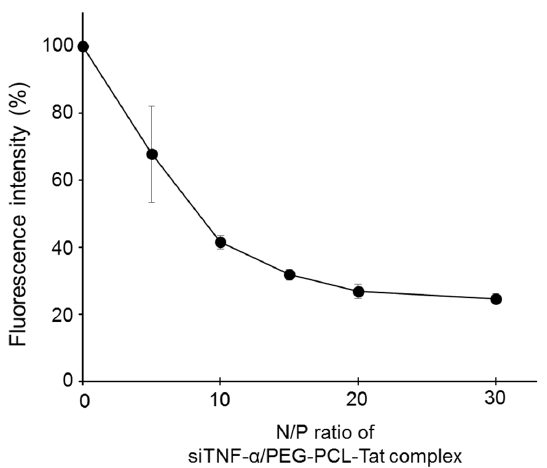
Figure 1. Complex formation ability with siTNF- α by PEG-PCL-Tat micelles. Complex formation ability with siTNF- α were determined using SYBR Green Exclusion Assay. The fluorescence of siTNF- α and PEG-PCL-Tat complexes at several N / P ratios from 0 to 30 were measured using a microplate reader. Each point represents the mean ± S.D. ( n = 3). Table 1. Particle size and zeta-potential of MPEG-PCL-Tat/siTNF- α complexes.